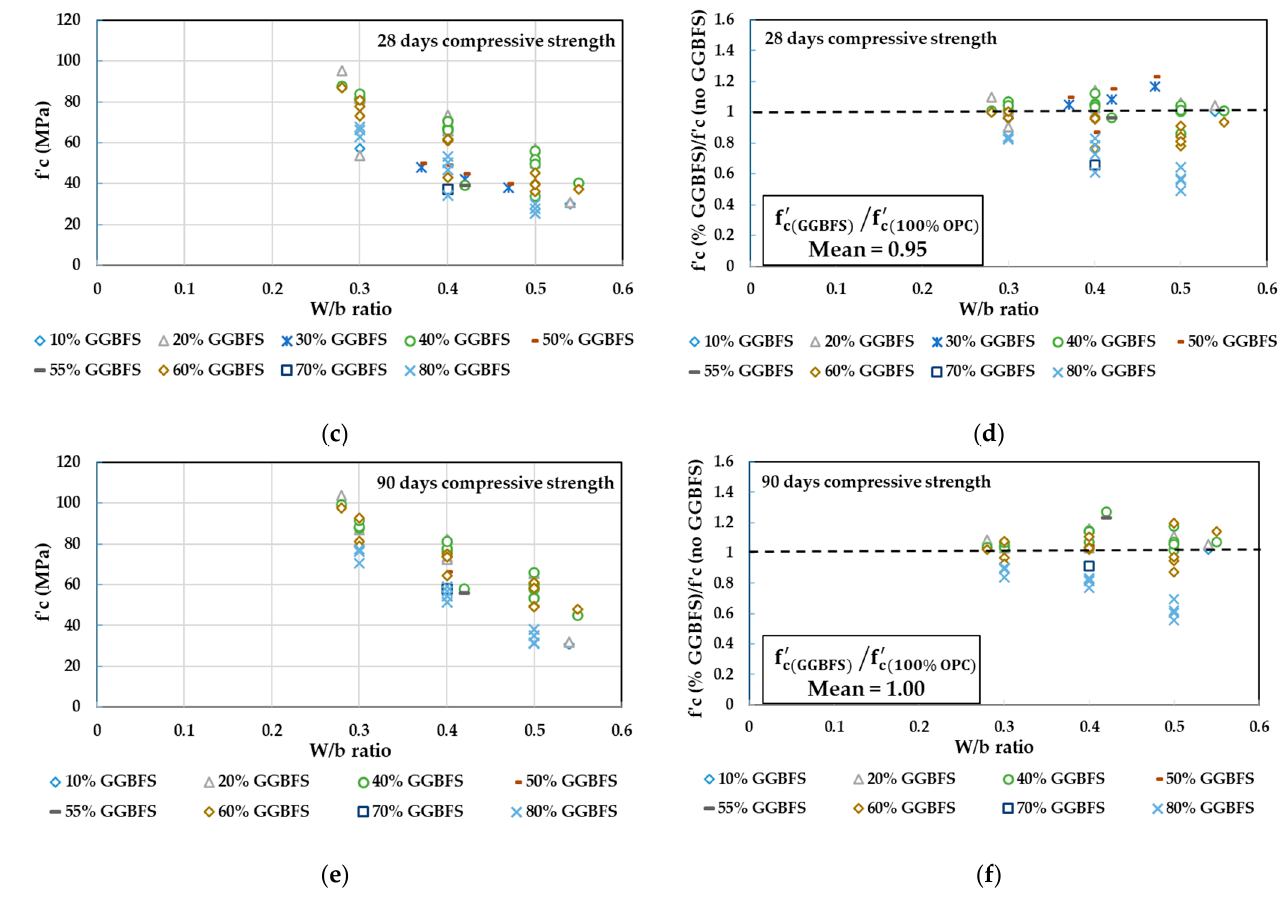
Figure 2. Concrete with Ground Granulated Blast Furnace Slag (GGBFS) as a partially replacing material for cement. Compressive strength vs. water binder (W/b) ratio at ( a ) 7 days; ( c ) 28 days; ( e ) 90 days. Ratio between compressive strength of concrete with GGBFS to concrete without GGBFS at ( b ) 7 days; ( d ) 28 days; ( f ) 90 days.